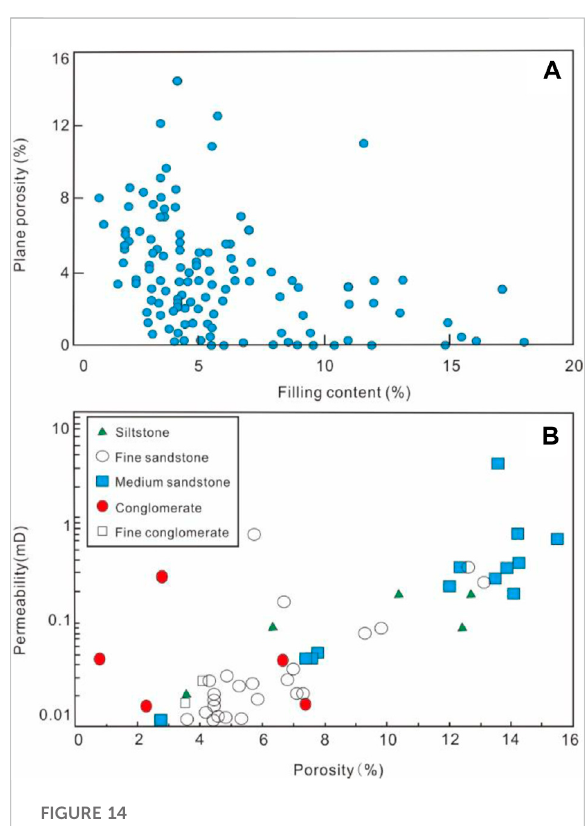
FIGURE 14 The cross plots of (A) plane porosity vs. fi lling content and (B) porosity vs. permeability of the P 3 w reservoir in Fukang